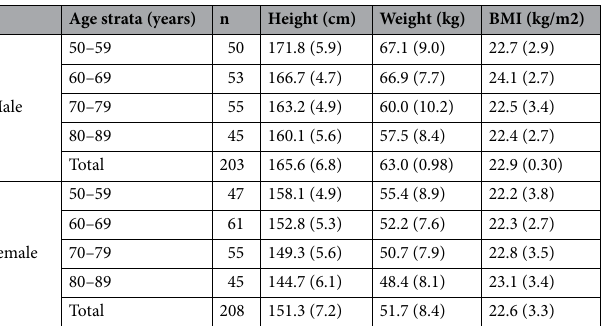
Table 1. Characteristics of 411 subjects in the Obuse study cohort. Values represent mean (standard deviation). BMI, Body Mass Index.